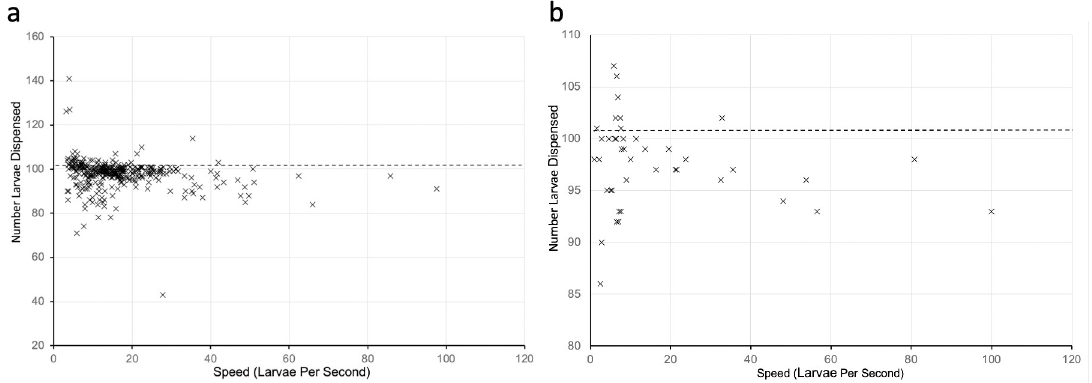
Fig 3. Relationship between larval rate and number dispensed. The relationship between the number of larvae per second passing the sensor and the number of (a) An . gambiae and (b) Ae . aegypti dispensed is shown.